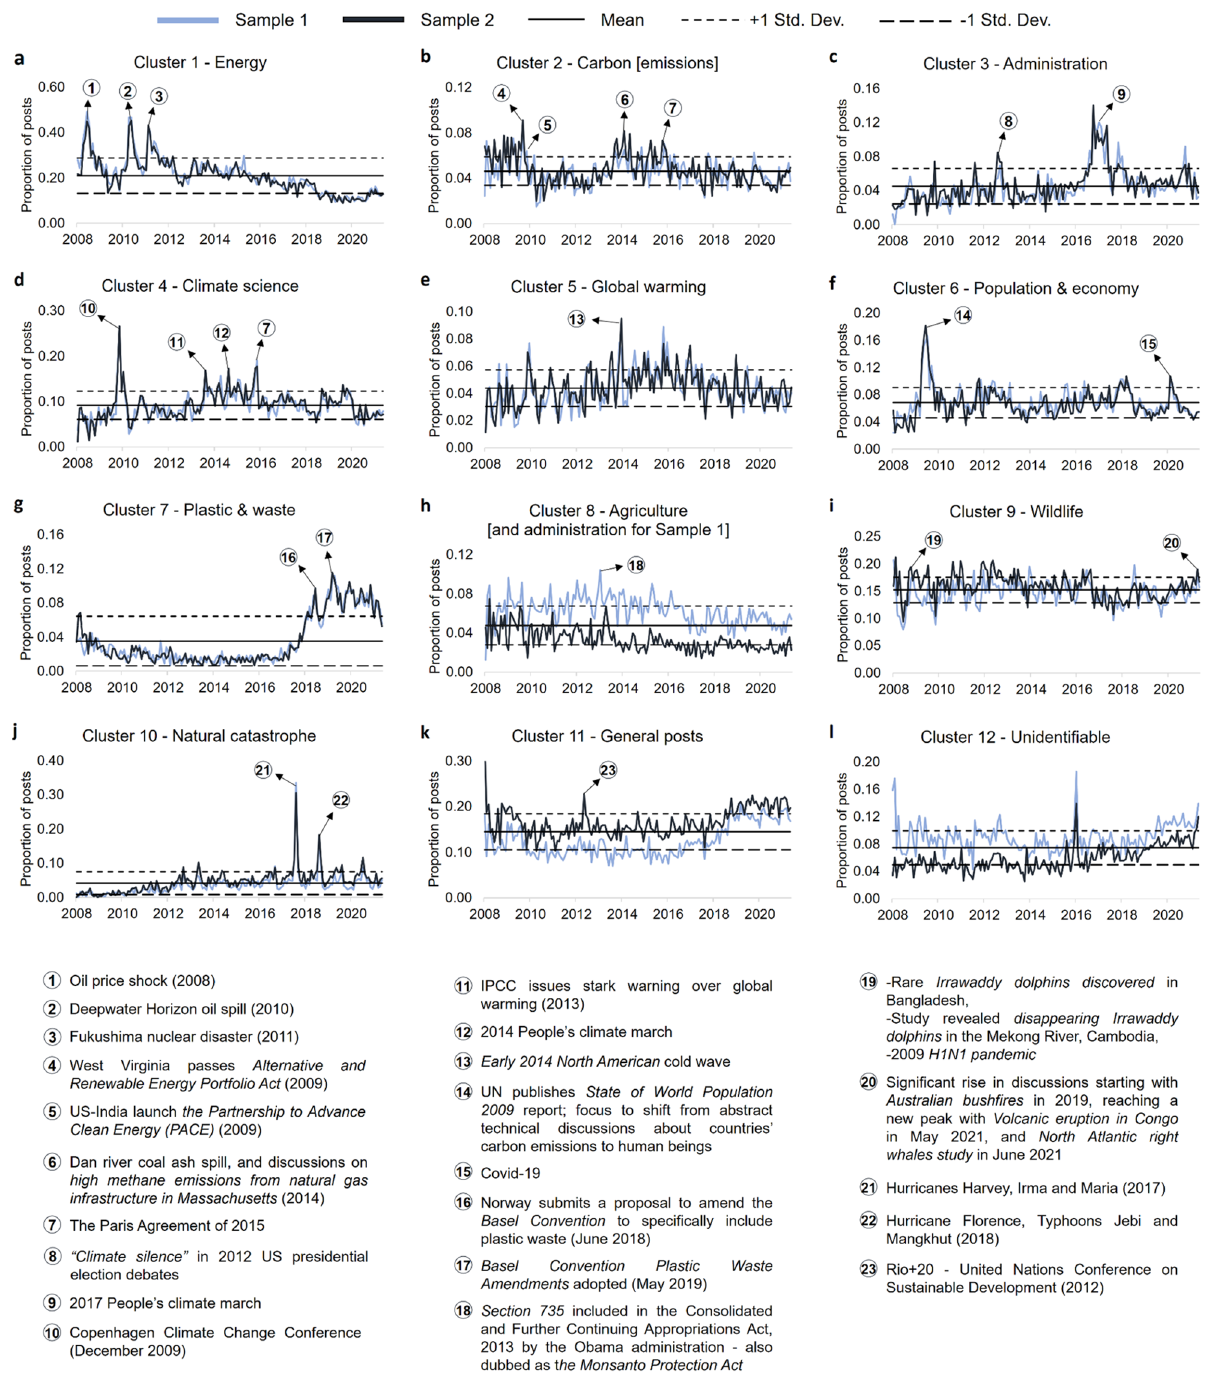
Figure 9. Proportion of posts in optimized clusters on a monthly basis (Jan 2008–Jun 2021). The figure shows the distribution of the proportion of the 12 optimized clusters on a monthly basis within sample 1 and 2 over the entire study period ( a – l ). The solid horizontal line depicts the overall mean of sample 1 and 2 whereas the two dotted lines above and below depict the ±1 sample standard deviation for both samples over the entire study period. All in all, within expectations, except for the three clusters namely Agriculture [and administration] (only Agriculture for sample 1) ( h ), General posts ( k ), and Unidentifiable ( l ), we observe that sample 1 and 2 time-series exhibit almost similar trend for the rest of the clusters ( a – g , i , j ), even in case of these three time- series, we observe a similar trend between sample 1 and 2 over time. This further strengthens our view that the underlying themes, on which the Reddit users are focussed in general, are uniform across the entire study